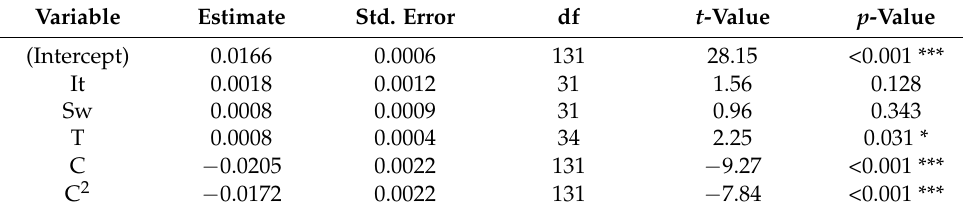
Table 4. Statistical analysis of the mean weight of a stone in 2020. In the model, the Belgian prove- nance is the standard to which the Italian (It) and Swedish (Sw) provenances are compared, and for the treatment in 2018 (T), the control is the standard to which the water limitation is compared.